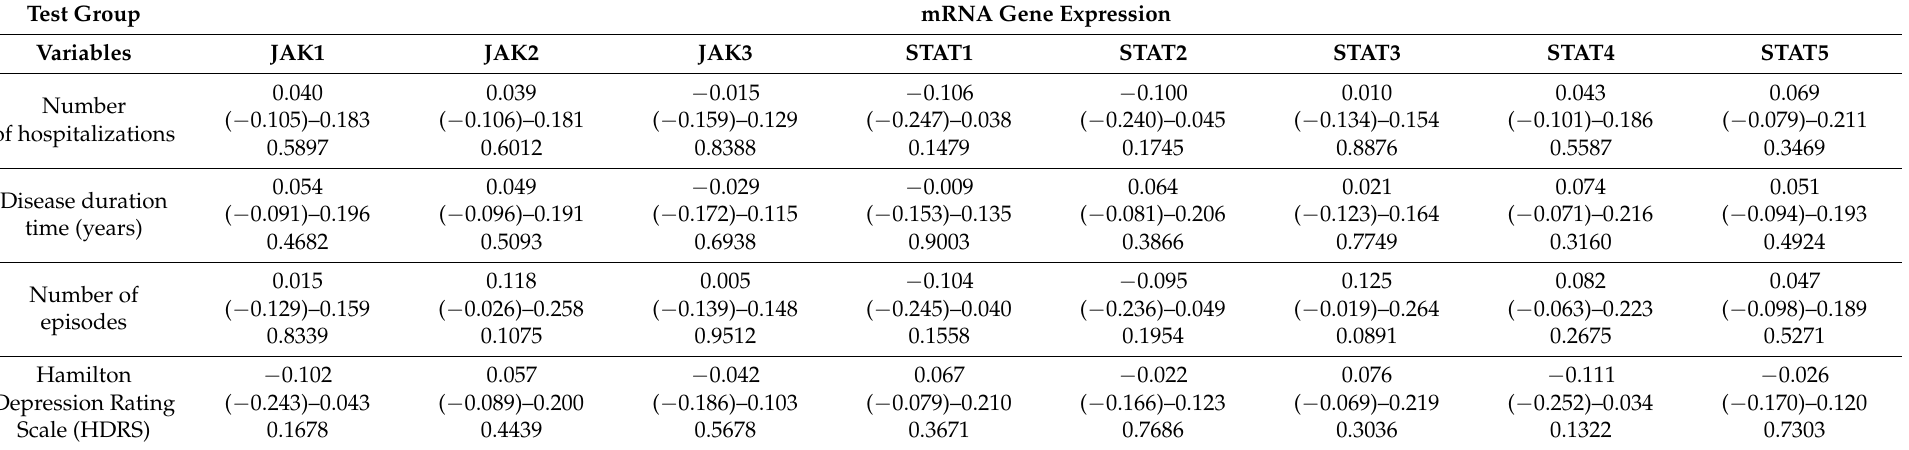
Table 4. Spearman’s rank correlation coefficients, their confidence limits and levels of statistical significance for the mRNA gene expression vs. selected clinical data in the test group.